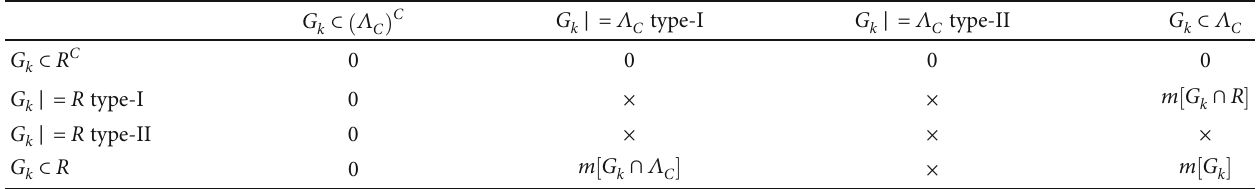
∩ Λ ∩ R (cid:2) under the combinations of Π ð G k C